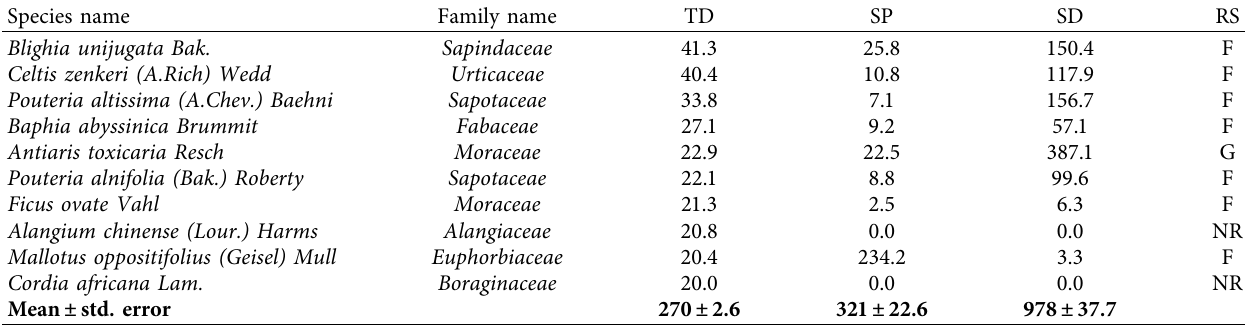
Table 13: Regeneration status of top ten species in site III (Gonchi–Gelesha).